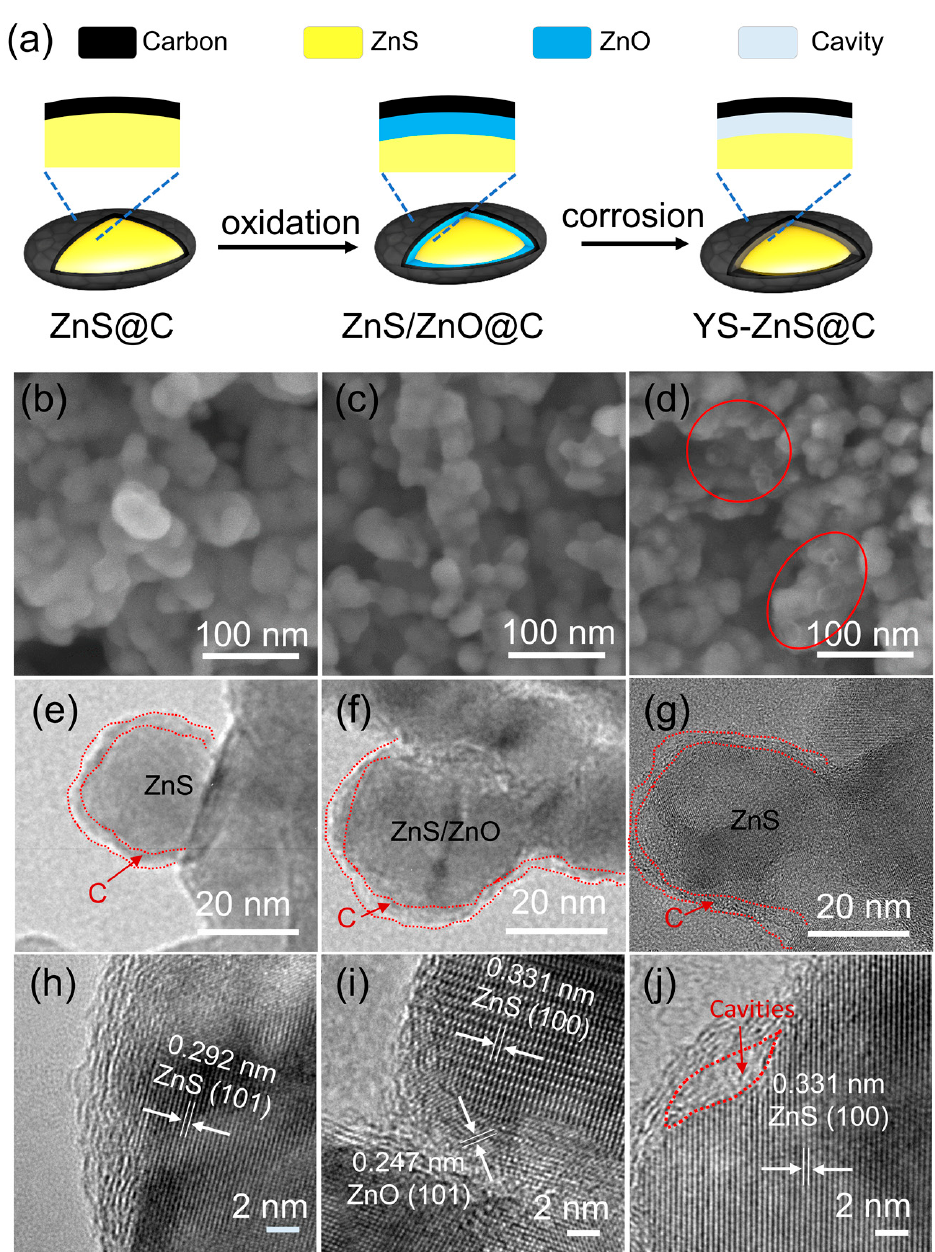
Figure 1. ( a ) Schematic illustrations for the formation process of yolk-shell structured